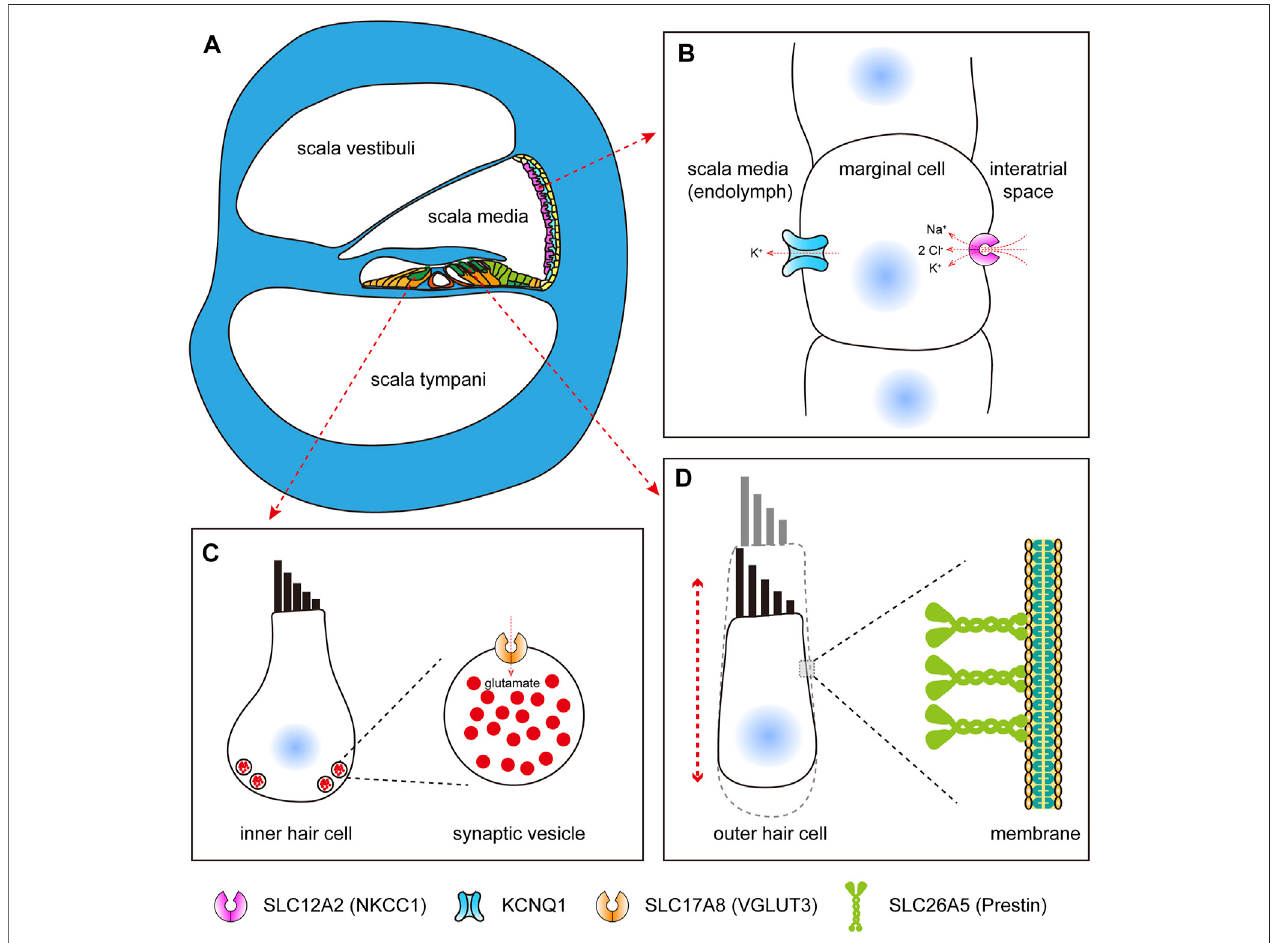
FIGURE 2 | SLC proteins expressed in mammalian cochlear cells. (A) Schematic diagram of mammalian cochlea (cross section). (B) Schematic diagram of SLC12A2, which functions in potassium recycling in striamarginal cells, maintainingthe endocochlear potential. (C) Schematic diagram ofSLC17A8,which functions in transporting glutamate in inner hair cells. (D) Schematic diagram of SLC26A5, which acts as motor proteins, driving somatic electromotility in outer hair